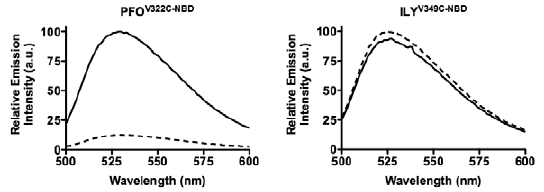
Figure 8. The b 4– b 5 interaction in cholesterol bound ILY. Cysteines were substituted for Val-322 in b 4 of PFO or the analogous Val-349 in b 4 of ILY and modified with NBD. Upon membrane binding b 5 rotates away from b 4, thus, the probe makes a transition from a nonpolar environment in the soluble monomer (solid line) to a polar environment in the membrane oligomer (dashed line), which results in the quenching of the NBD fluorescence [25]. The data are represen- tative of 3